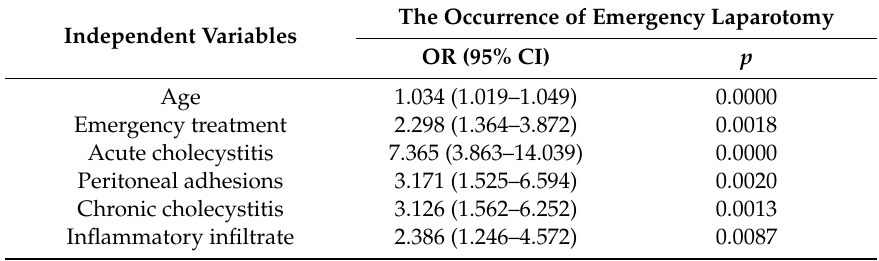
Table 8. Statistical significance of the factors in the regression model with all explanatory variables.